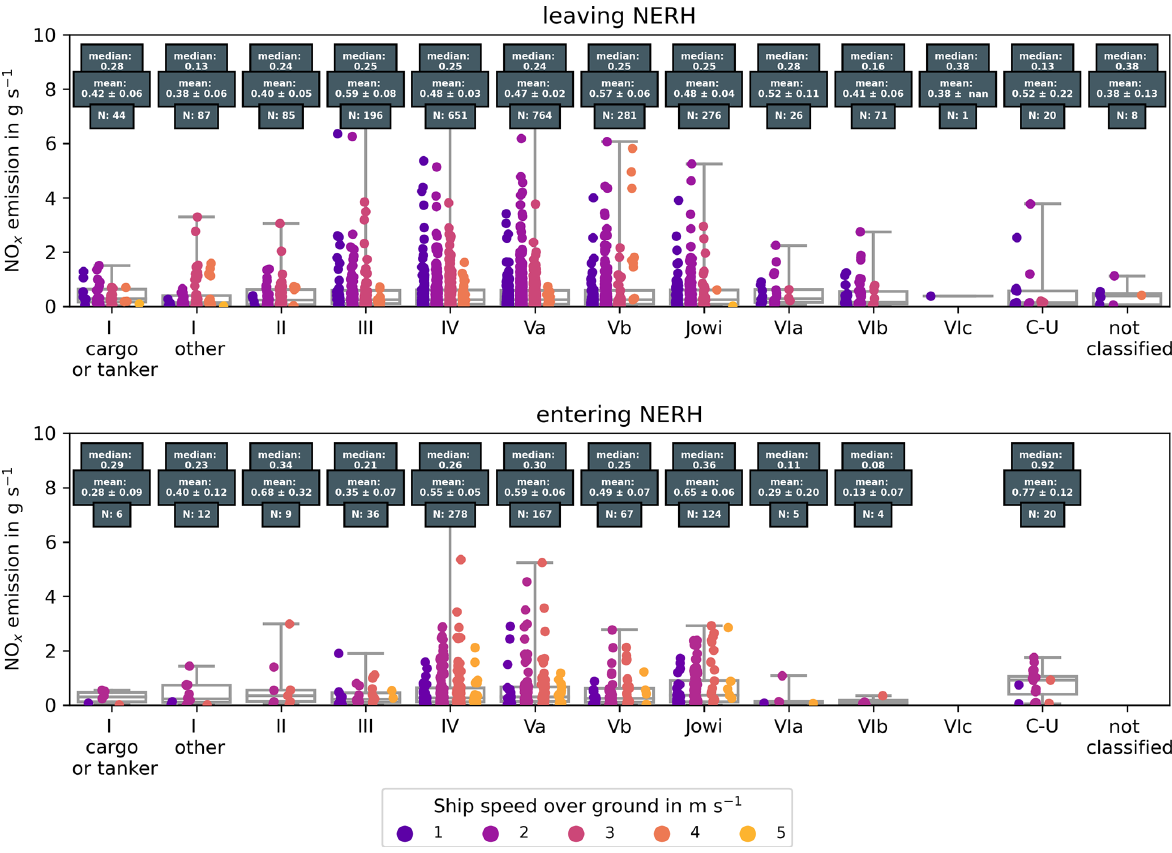
Figure 11. NO x emission rates for all ship classes, as derived from measurements at NERH. Single measurements are colour coded to the respective mean ship speed during the